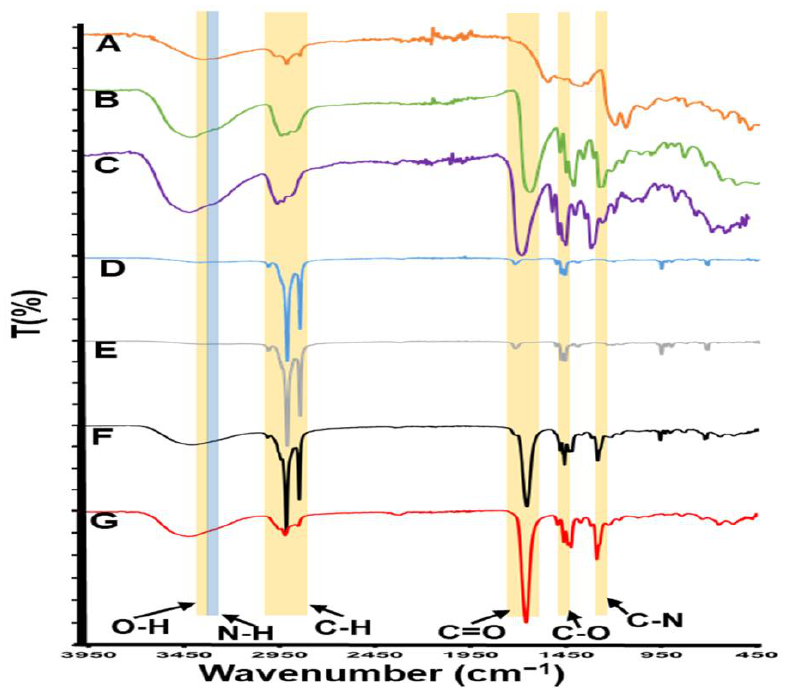
Figure 2. FTIR spectra of ( A ) GO, ( B ) PVP, ( C ) mGO, ( D ) AuNRs, ( E ) GO@AuNRs, ( F ) PVP @AuNRs, and ( G ) mGO@AuNRs.